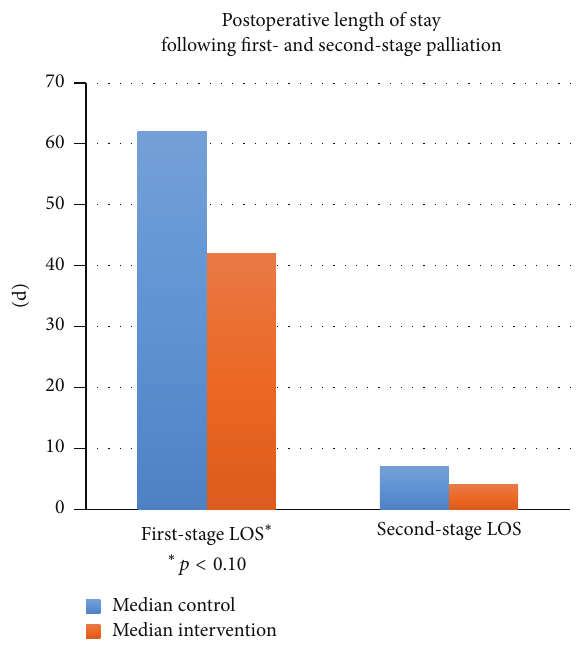
Figure 3: Median postoperative length of stay.